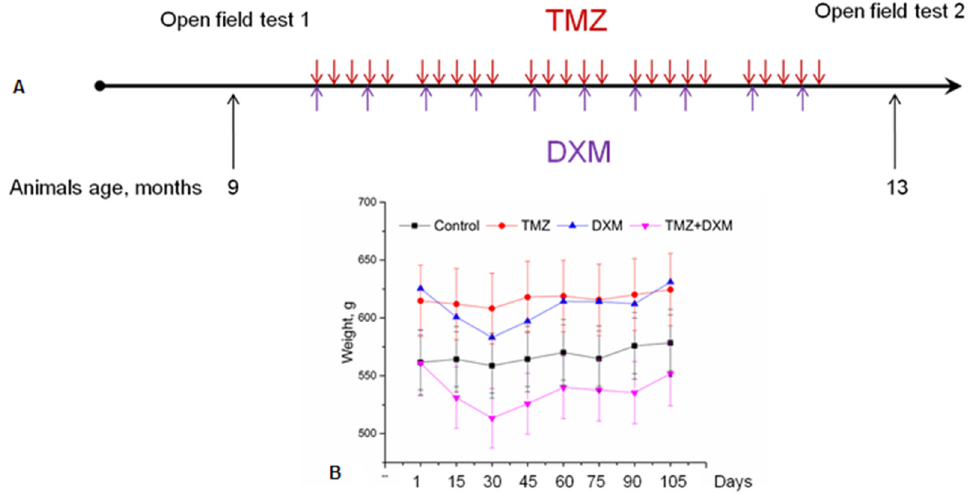
Figure 1. Experimental design of the study. ( A ) Scheme of TMZ and DXM administration to the Wistar rats. ( B ) Weight of experimental animals. All data are expressed as mean ± SD (ORIGIN 8.5 software). TMZ – temozolomide, DXM – dexamethasone.